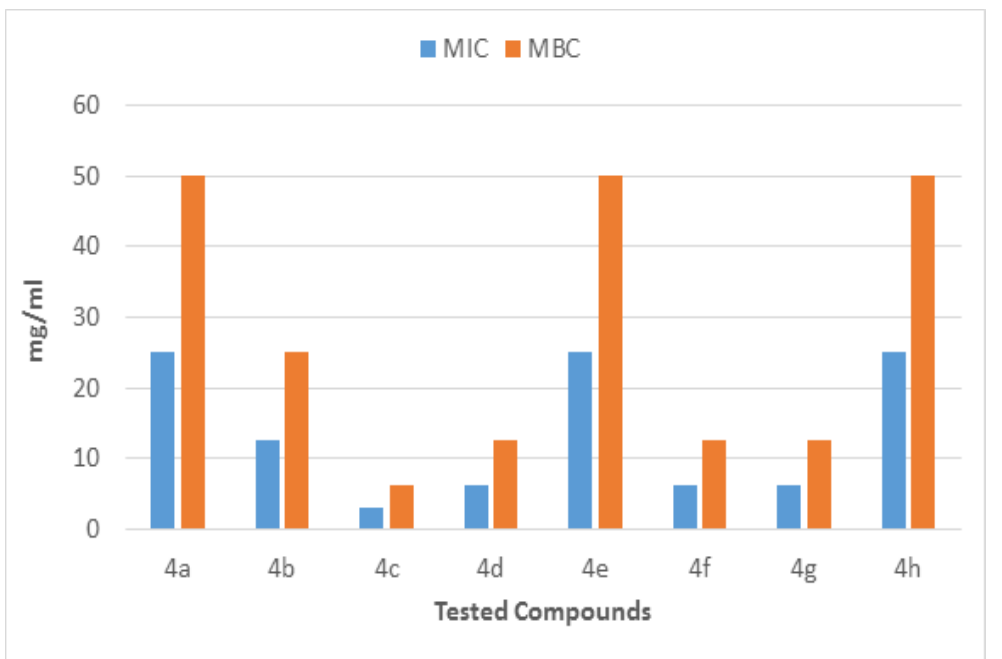
Figure 4. MIC and MBC of each fraction of compounds ( 4a – h ) against ESBL-producing E. coli ST131.